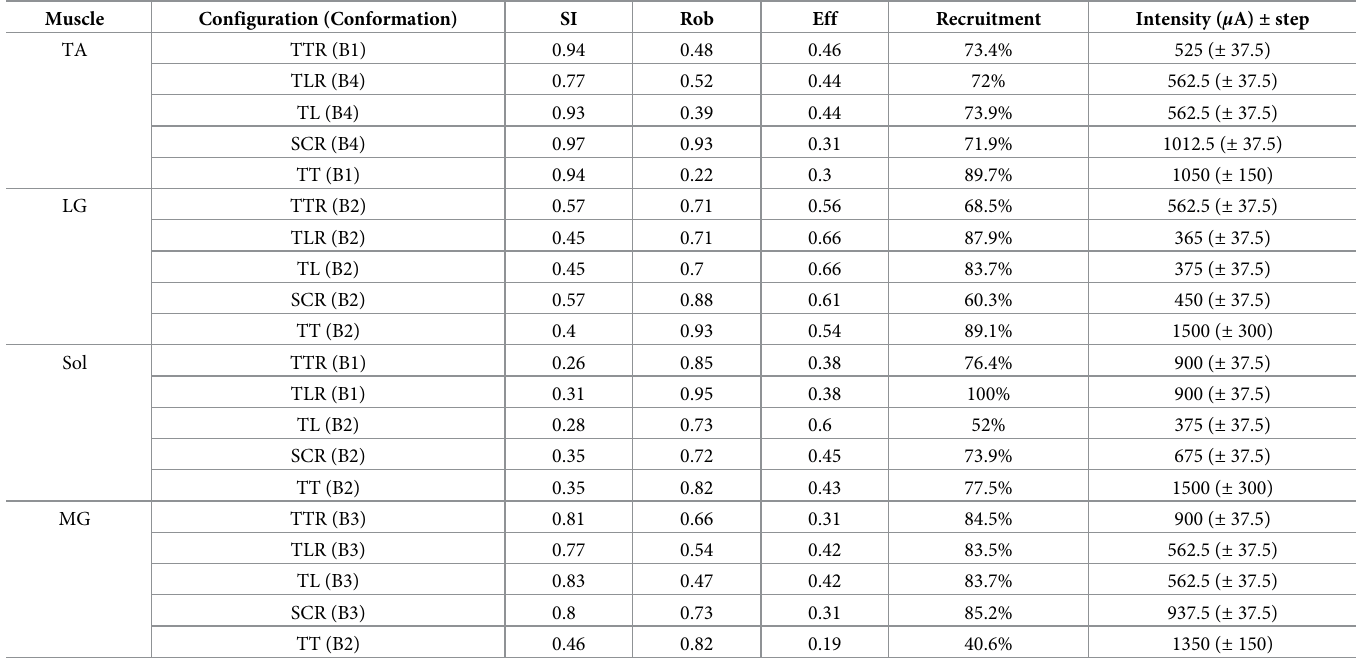
Table 4. Rabbit 1. SI, Rob and Eff. Indexes are presented for each muscle and configuration (with optimal cathode conformation for each muscle). Muscle Configuration (Conformation)